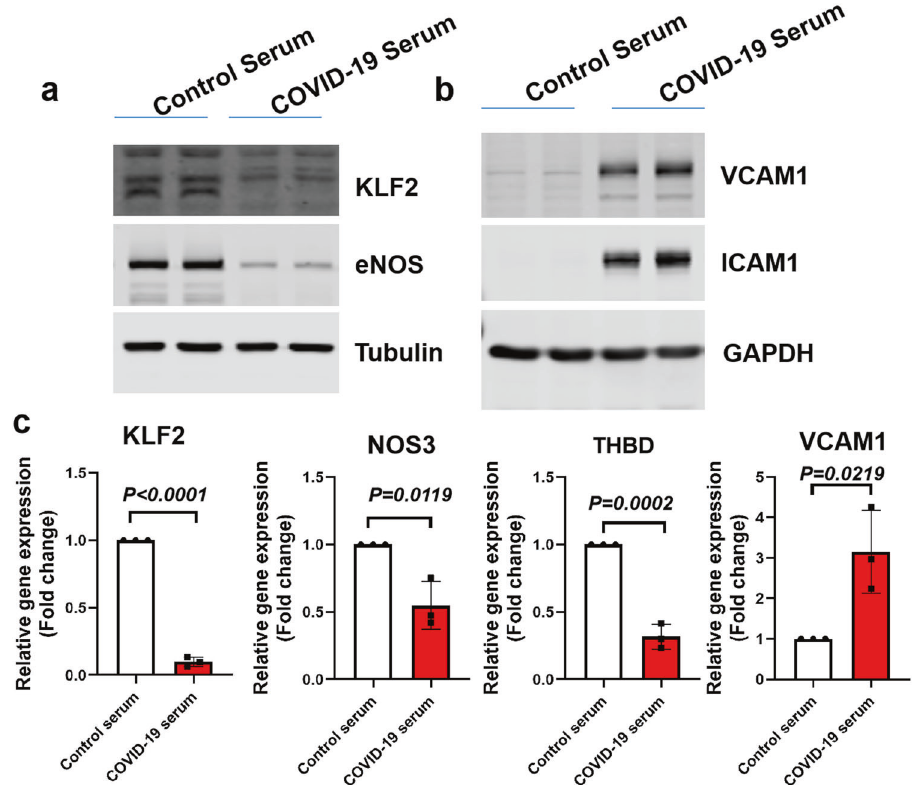
Fig. 1 COVID-19 patient-serum-treated human endothelial cells show KLF2 downregulation, eNOS downregulation, and endothelial in fl ammation. a HUVECs were treated with control serum (20%) or COVID-19 serum (20%) for 24 h before protein was collected for western blot analysis of KLF2 and eNOS protein expression. N = 3. b HUVECs were treated with control serum (20%) or COVID-19 serum (20%) for 24 h before protein was collected for western blot analysis of ICAM1 and VCAM1 protein expression. N = 3. c HUVECs were treated with control serum (20%) or COVID-19 serum (20%) for 24 h before RNA was collected for the analysis of genes indicated. N =